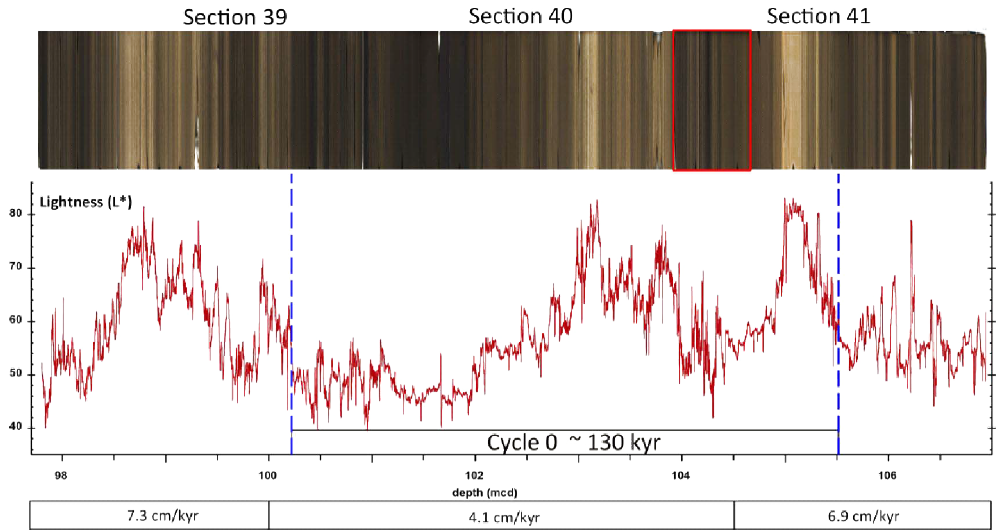
Figure 5. Onset of OAE 2 in Tarfaya well SN ◦ 4. The red box indicates transition from homogenous to laminated sediments. Note the increase in lightness variability.